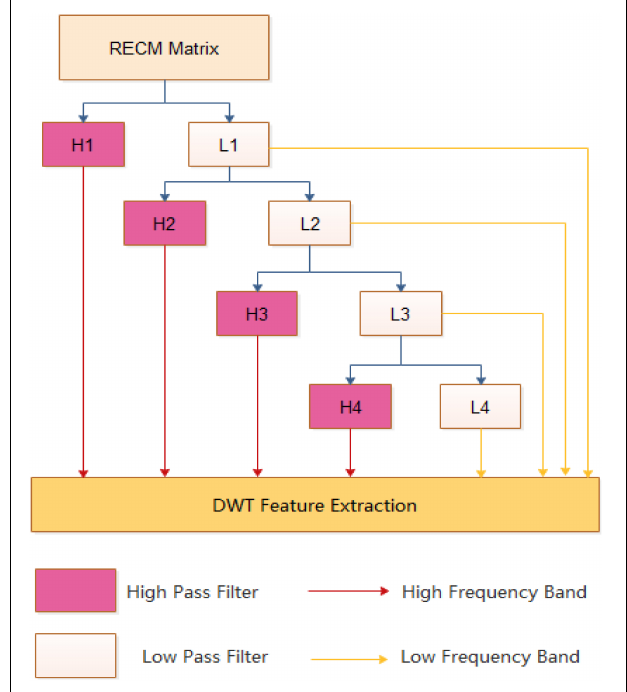
FIGURE 2 | An example of a discrete wavelet transform